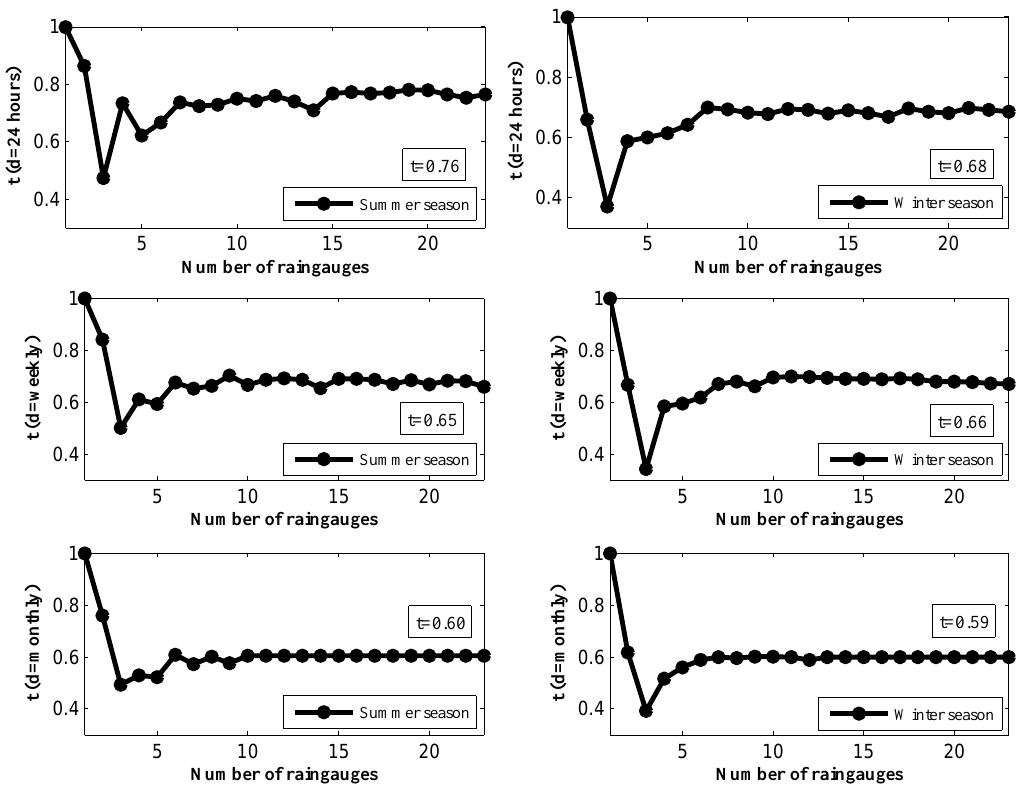
Fig. 3. Coefficient of nontransferred information for sampling time intervals of d = 24h, 1 week and 1 month for summer (left) and winter (right) seasons in Rome. The maximum content of non-redundant information is quoted in the box for each sampling time. This result is the value assumed by t , corresponding to the last raingauge added to the network. The same values are presented on a semi-log scale in Fig. 5 for each